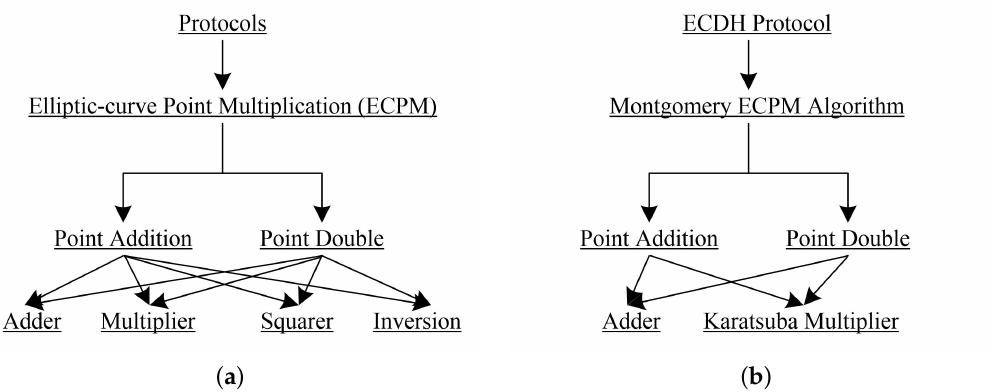
Figure 1. Typical and adopted ECC hierarchies. ( a ) A typical ECC hierarchy; ( b ) adopted ECC hierarchy in this